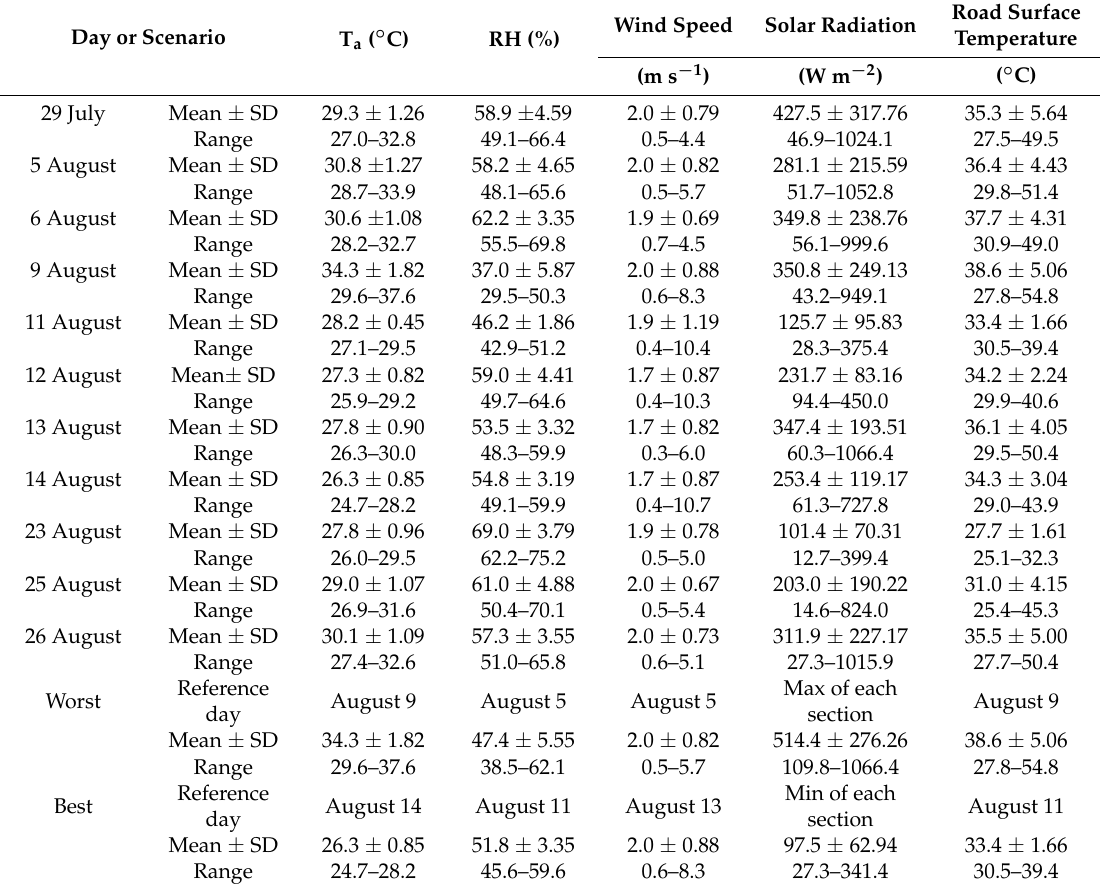
Table 3. Mean and standard deviation (SD) of meteorological variables for each day and